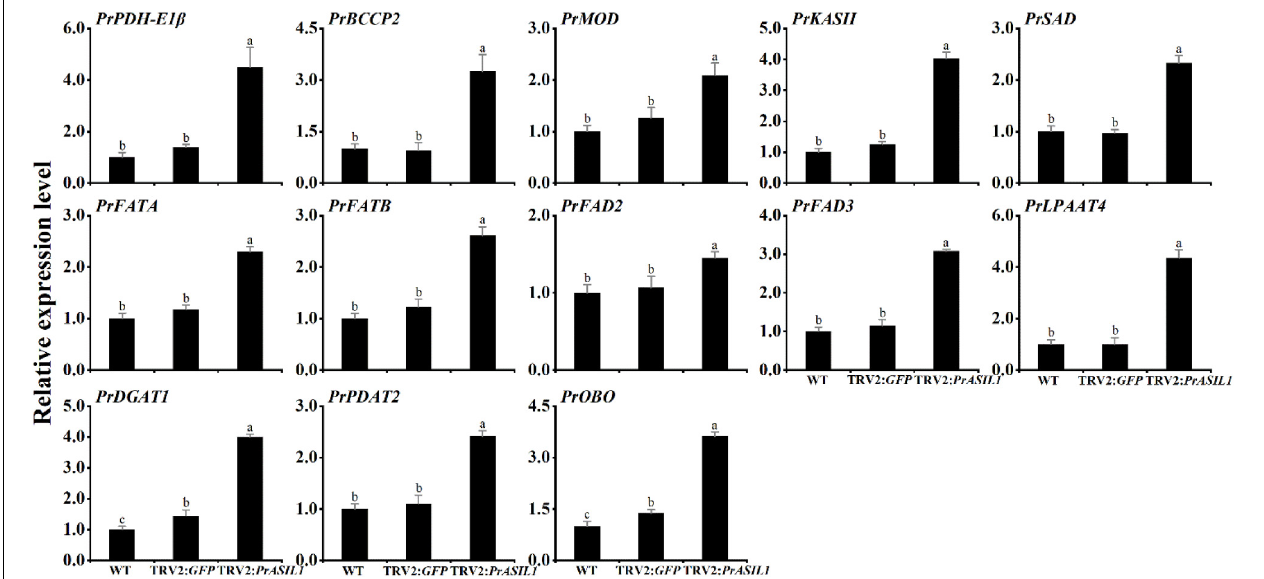
FIGURE 8 | Comparison of the expression levels of FA and TAG biosynthetic genes among the WT, TRV2: GFP control, and PrASIL1 -silenced plants. Relative expression of PrASIL1 was normalized to 18S-26S ITS and calibrated to the levels of WT leaves. Values are mean ± SD ( n = 3). Different letters indicate significant difference at P < 0.05, as confirmed by one-way ANOVA with Tukey’s